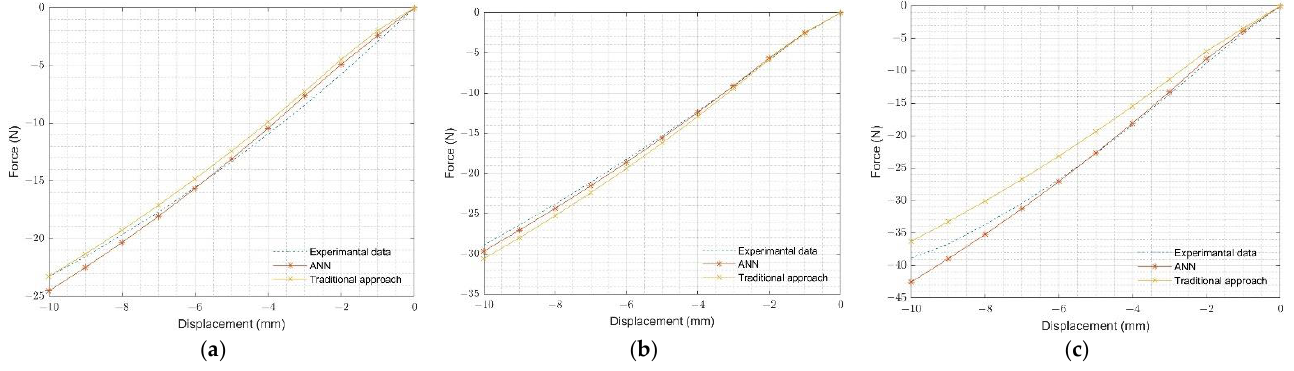
Figure 12. Comparison of O-ring multi-contact experimental and FEA results: ( a ) neoprene rubber, ( b ) natural rubber, and ( c ) silicone rubber.